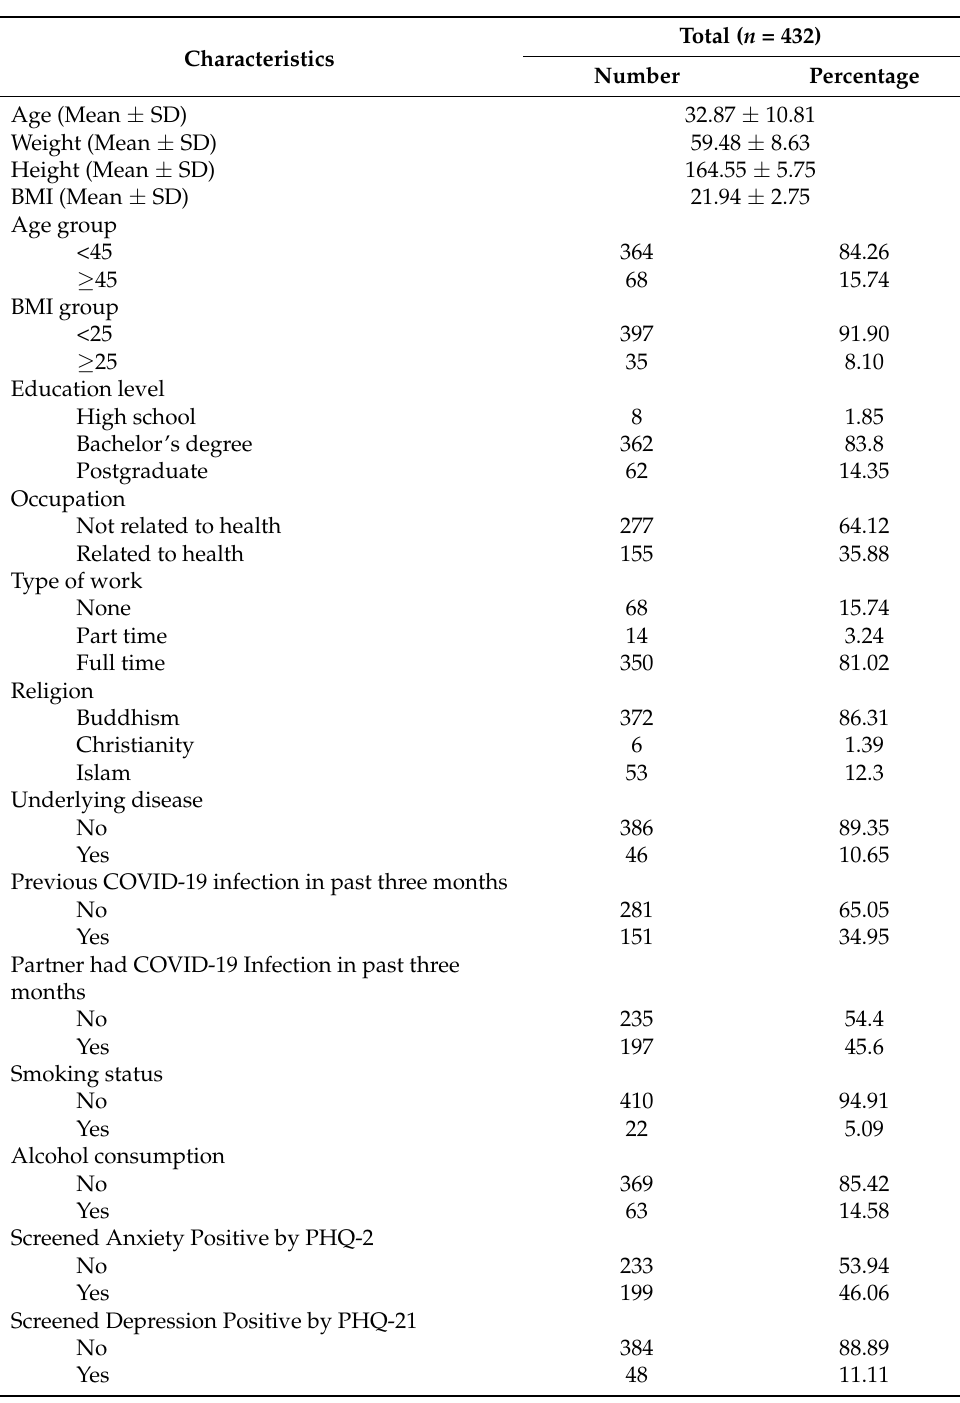
Table 1. Demographic